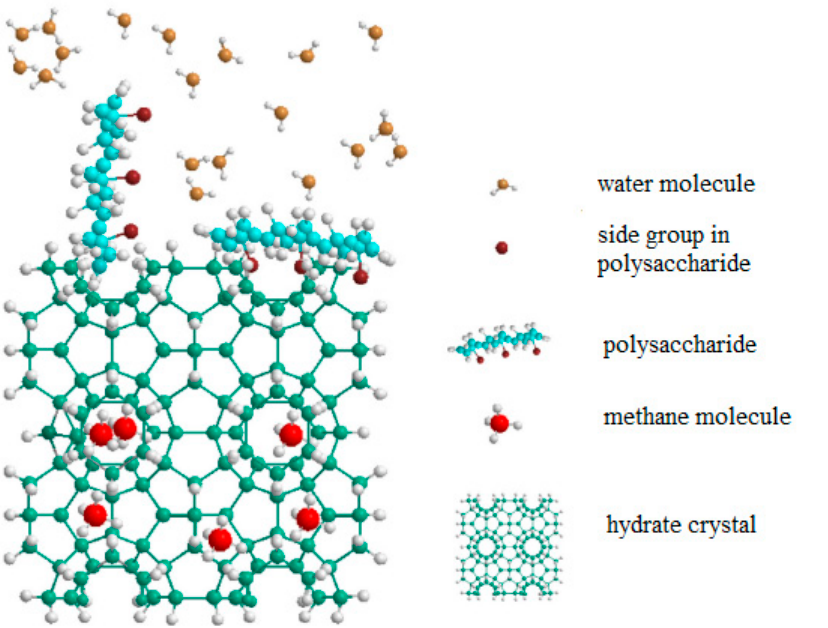
Figure 8. Schematic of the possible hydrate growth inhibition mechanisms of polysaccharides Reproduced with permission from Ref. [79] Copyright 2019 Elsevier.